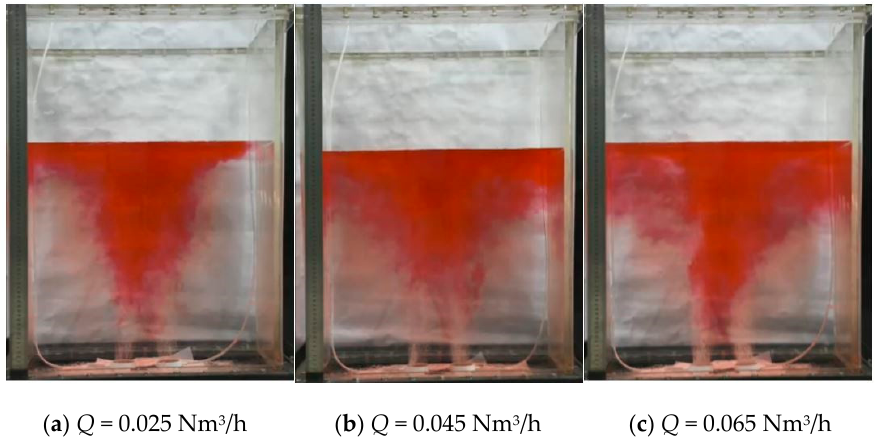
Figure 10. Tracer patterns as a function of bottom blowing flowrates at a bath depth of 500 mm.